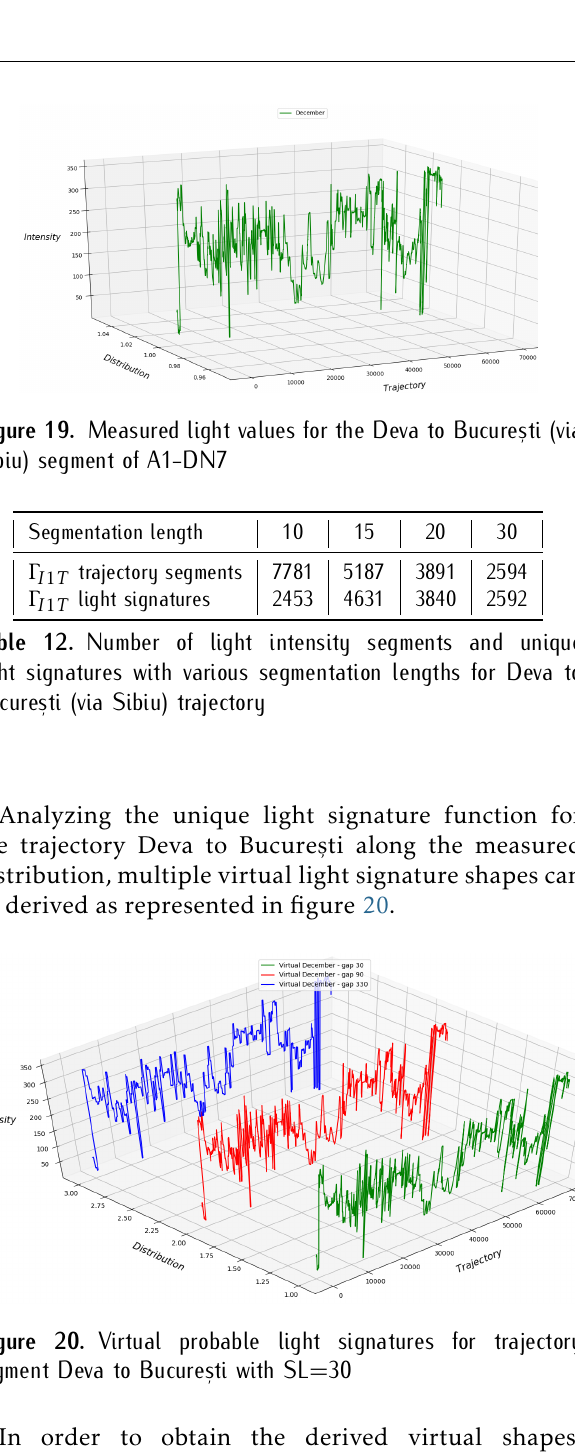
Figure 20. Virtual probable light signatures for trajectory segment Deva to Bucures ti with ,